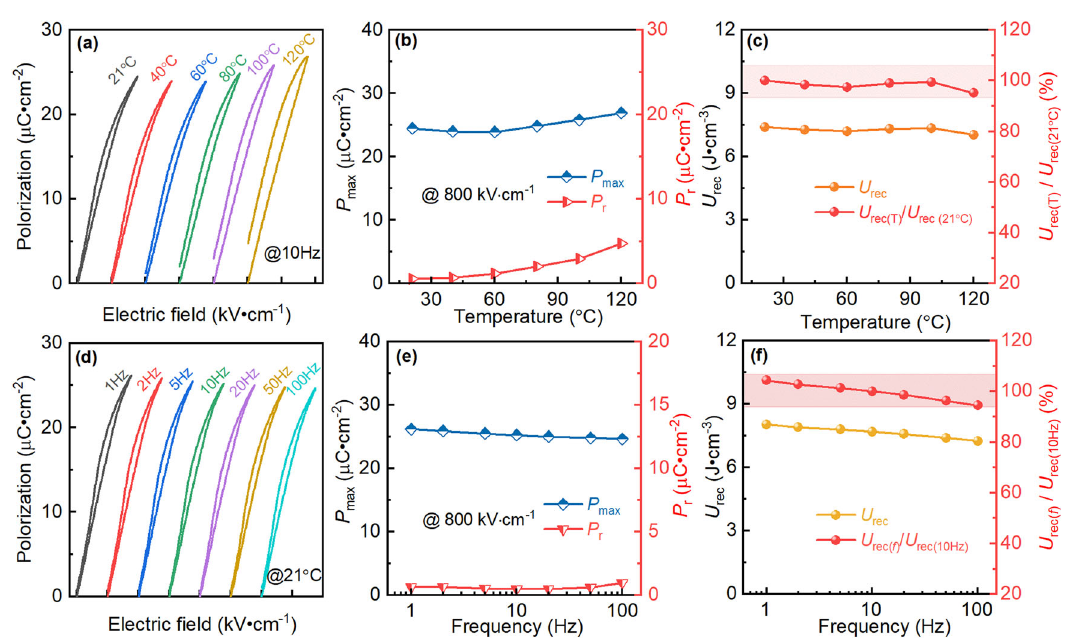
Fig. 6 | Reliabilityofenergy storage performance undervarious conditions for theSANT MLCCs. Temperaturedependenceof unipolar P – Eloops ( a ), P max and P r ( b ), U rec and U rec (T)/ U rec (21°C) ( c ) measured at 800kVcm − 1 and 10Hz, and the